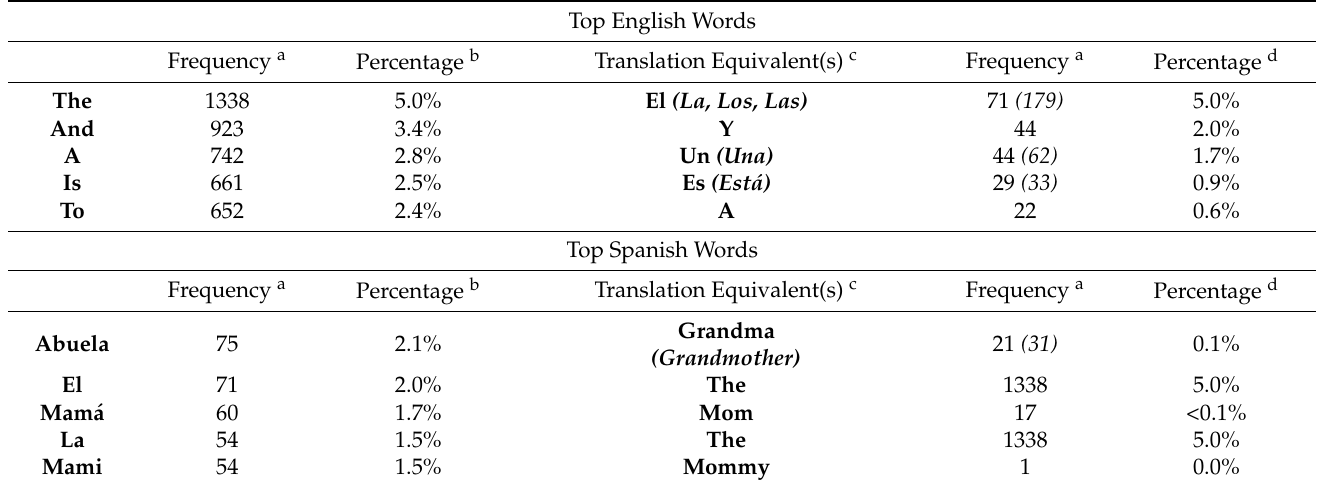
Table 3. Top 5 most frequent words per language and translation equivalents.